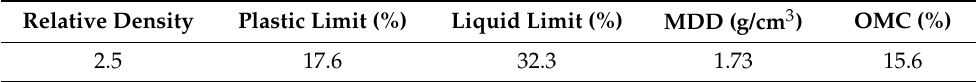
Table 1. Physical performance indices of the